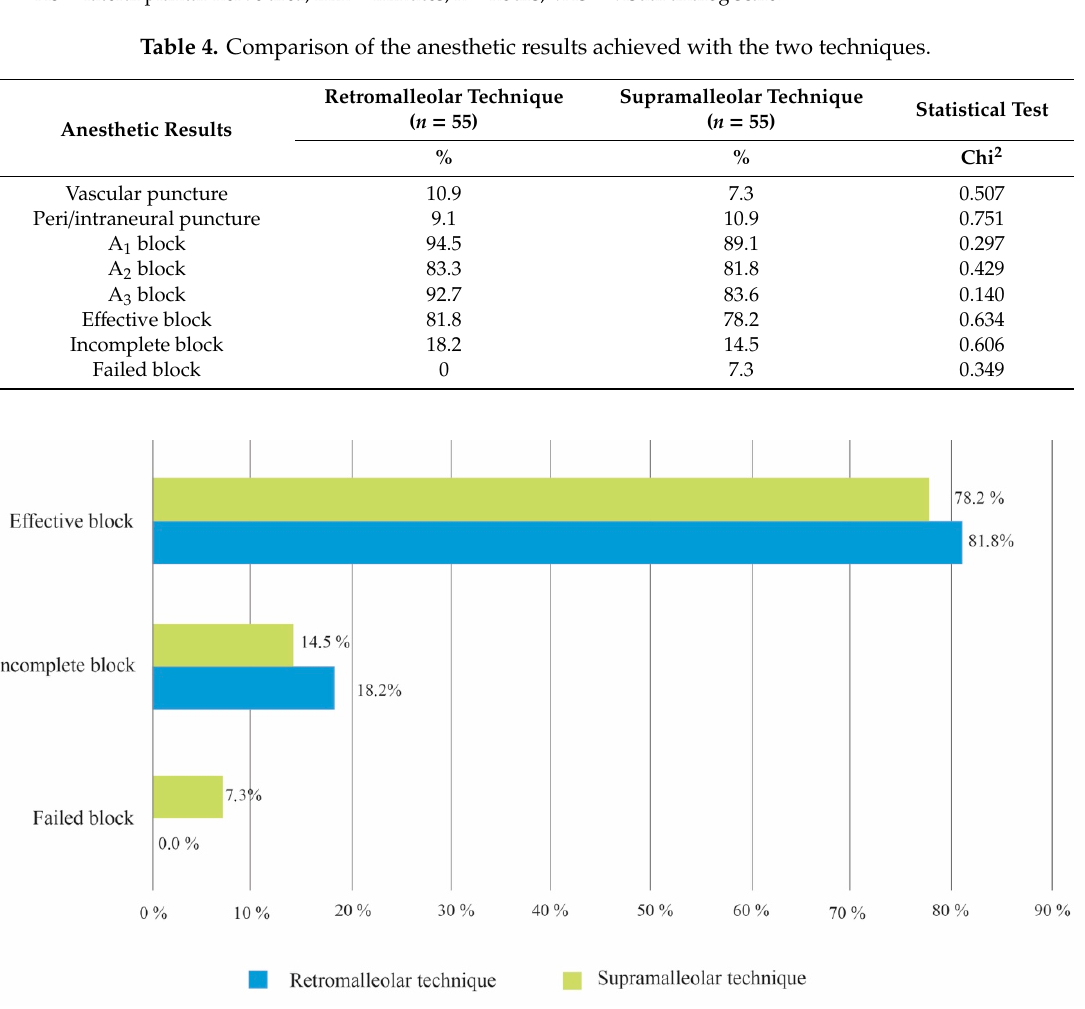
Figure 5. Comparison of the anesthetic results achieved with the two techniques.